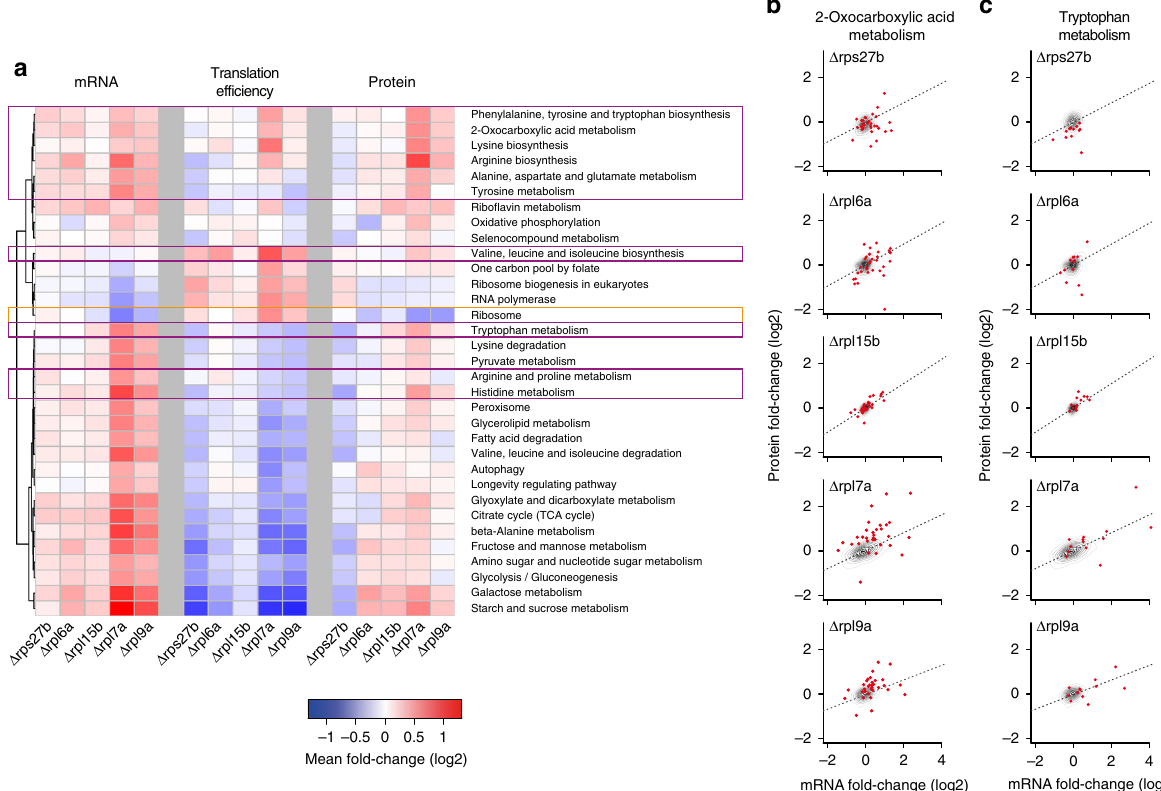
Fig. 1 RPKO strains exhibit changes at multiple levels of gene expression. a Heatmap depicts mean fold-changes of components of the indicated KEGG pathways at mRNA (measured by mRNA-seq), translation ef fi ciency (calculated by dividing the normalized read count in Ribo-seq by the normalized read count in mRNA-seq), and protein (measured by proteomics) levels. The orange box highlights ribosome-related genes, whereas purple boxes highlight gene categories involved in amino acid biosynthesis and metabolism. b , c Speci fi c examples of KEGG pathways whose components are regulated b translationally (2-oxocarboxylic acid metabolism) or c transcriptionally (tryptophan metabolism). Red dots represent genes from the indicated KEGG pathways and the contour plots refer to all